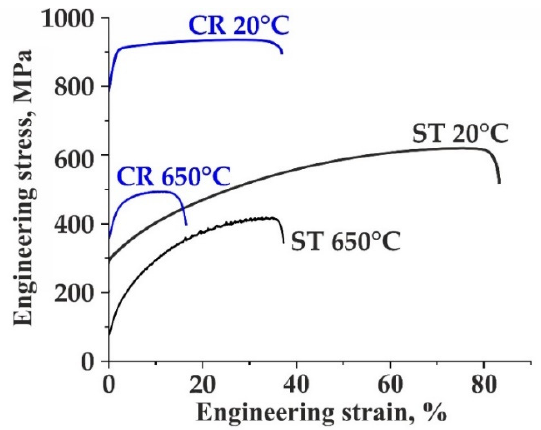
Figure 9. Engineering stress–engineering strain curves of some samples of the steel after ST and CR at 20 and 650 °C.